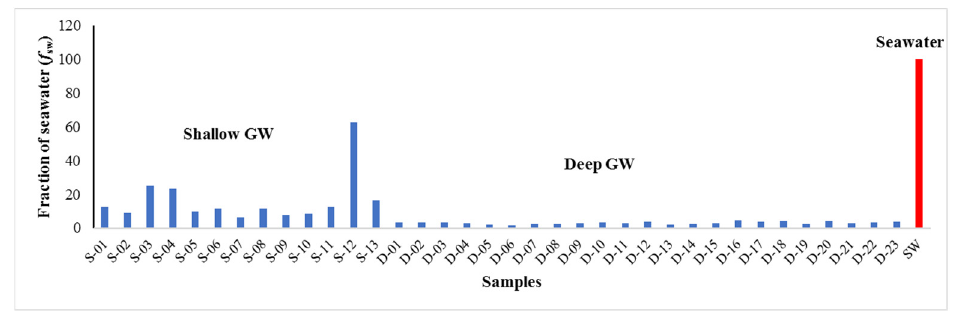
Figure 14. Diagram shows fraction of seawater for GW samples from shallow and deep coastal aquifers with seawater sample reference.